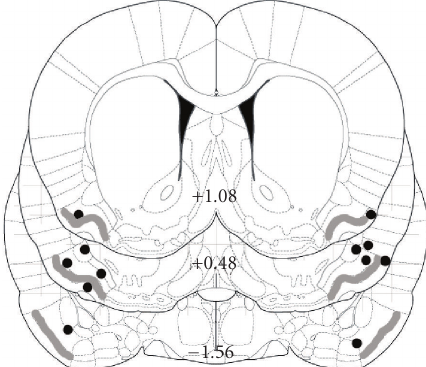
Figure 4: Reconstruction of experiment 3 cannula tip locations in infused rats (black dots) on stereotaxic plates from [20]. All tips were within the anterior piriform cortex, ranging from 1.0 anterior to 1.60mm posterior to Bregma. Gray line represents layer II of the piriform